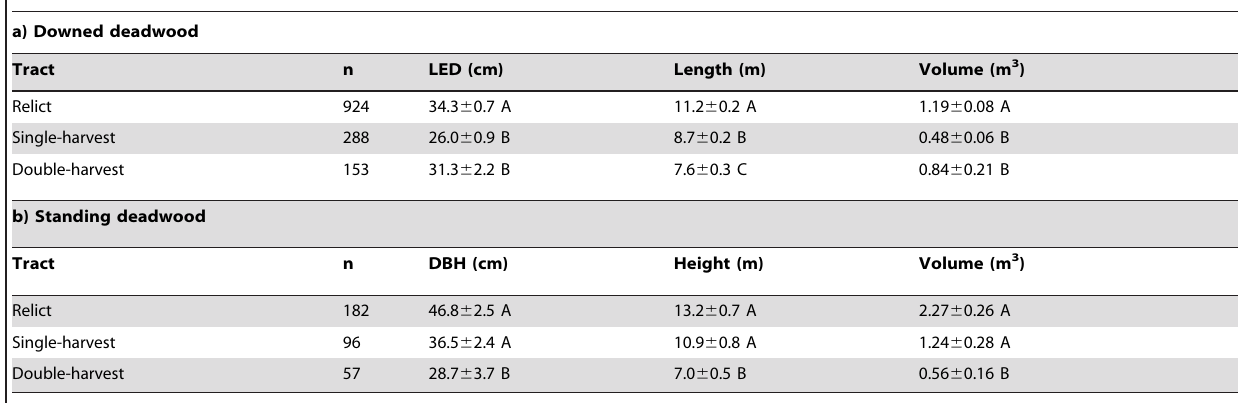
Table 1. Coarse woody debris piece